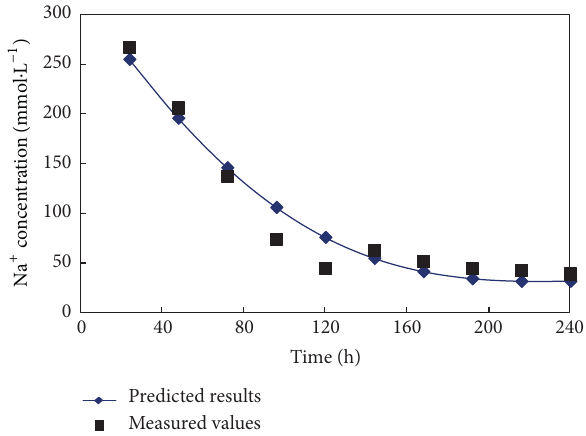
Figure 6: Comparison of the measured values and predicted results for the Na + concentration of the soil leachate in a penetration experiment.